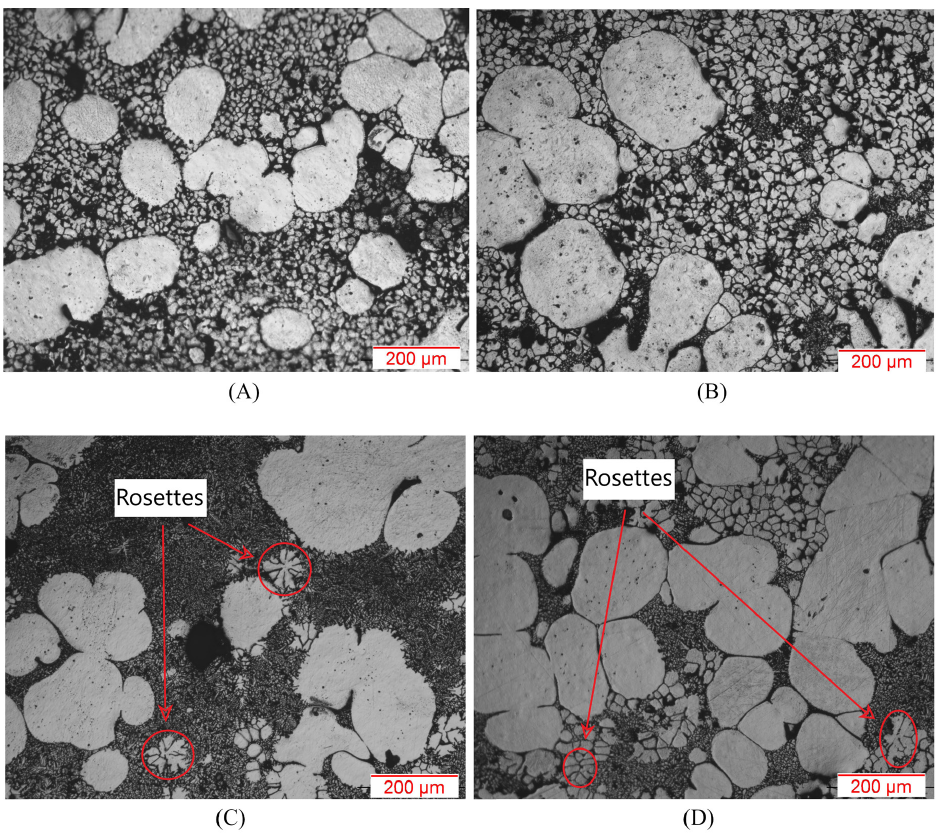
Figure 5. Evolution of the 6 mm samples processed at 595°C in different stirring times. (A) 1-minute; (B) 2-minutes; (C) 4-minutes and (D)